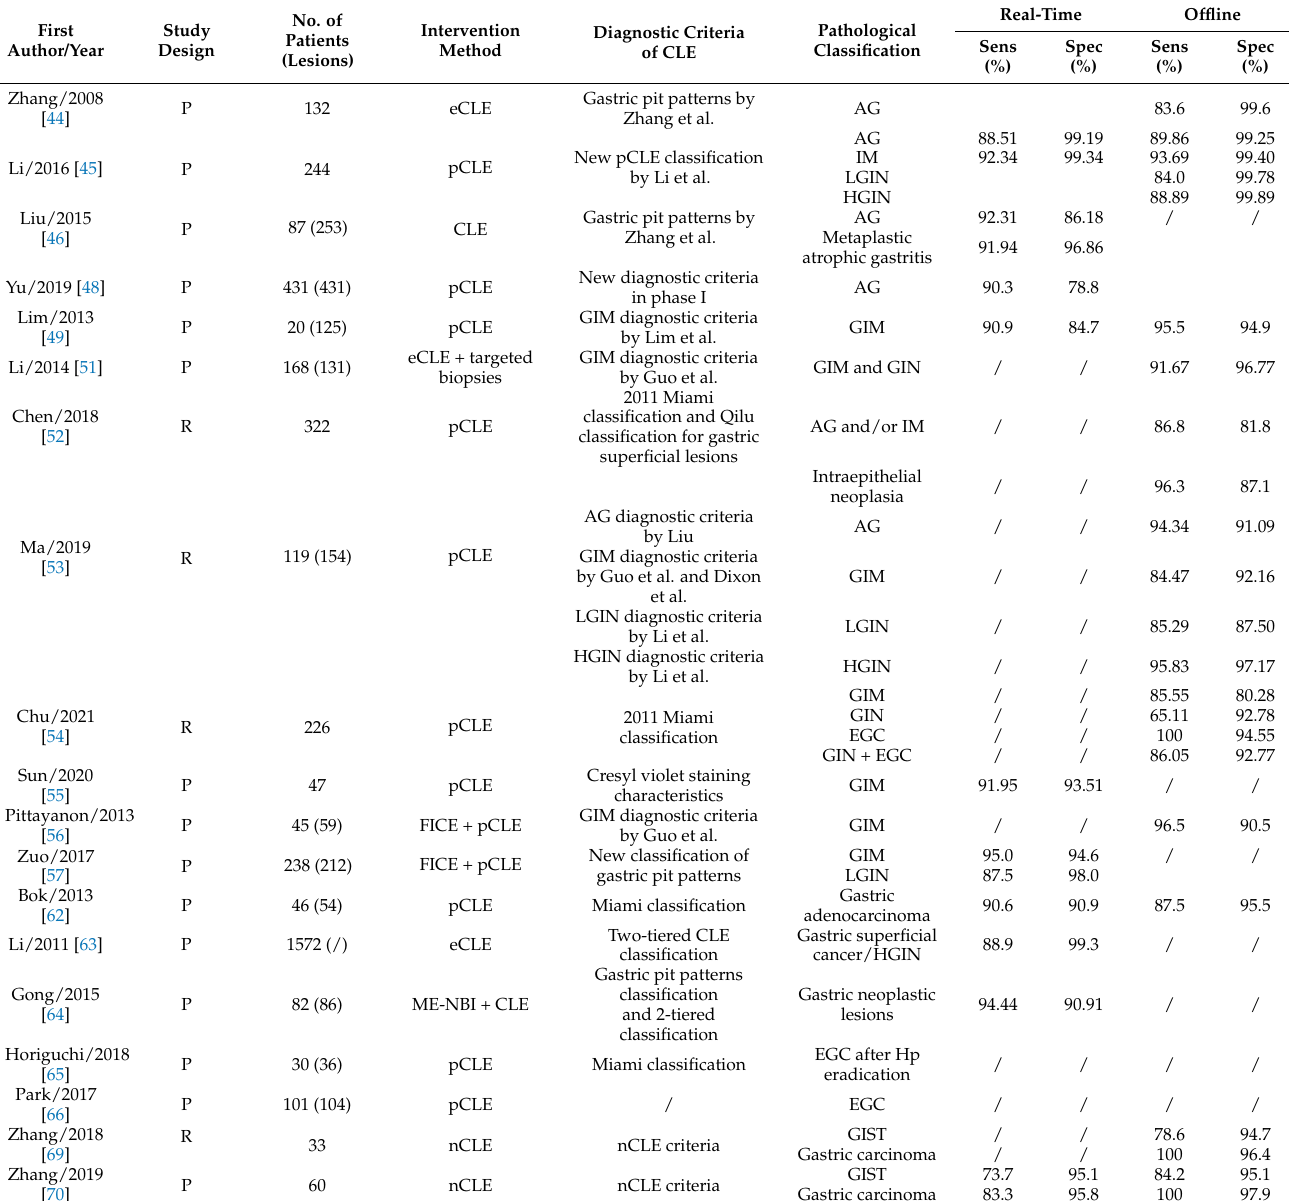
Table 3. Diagnostic value of CLE in